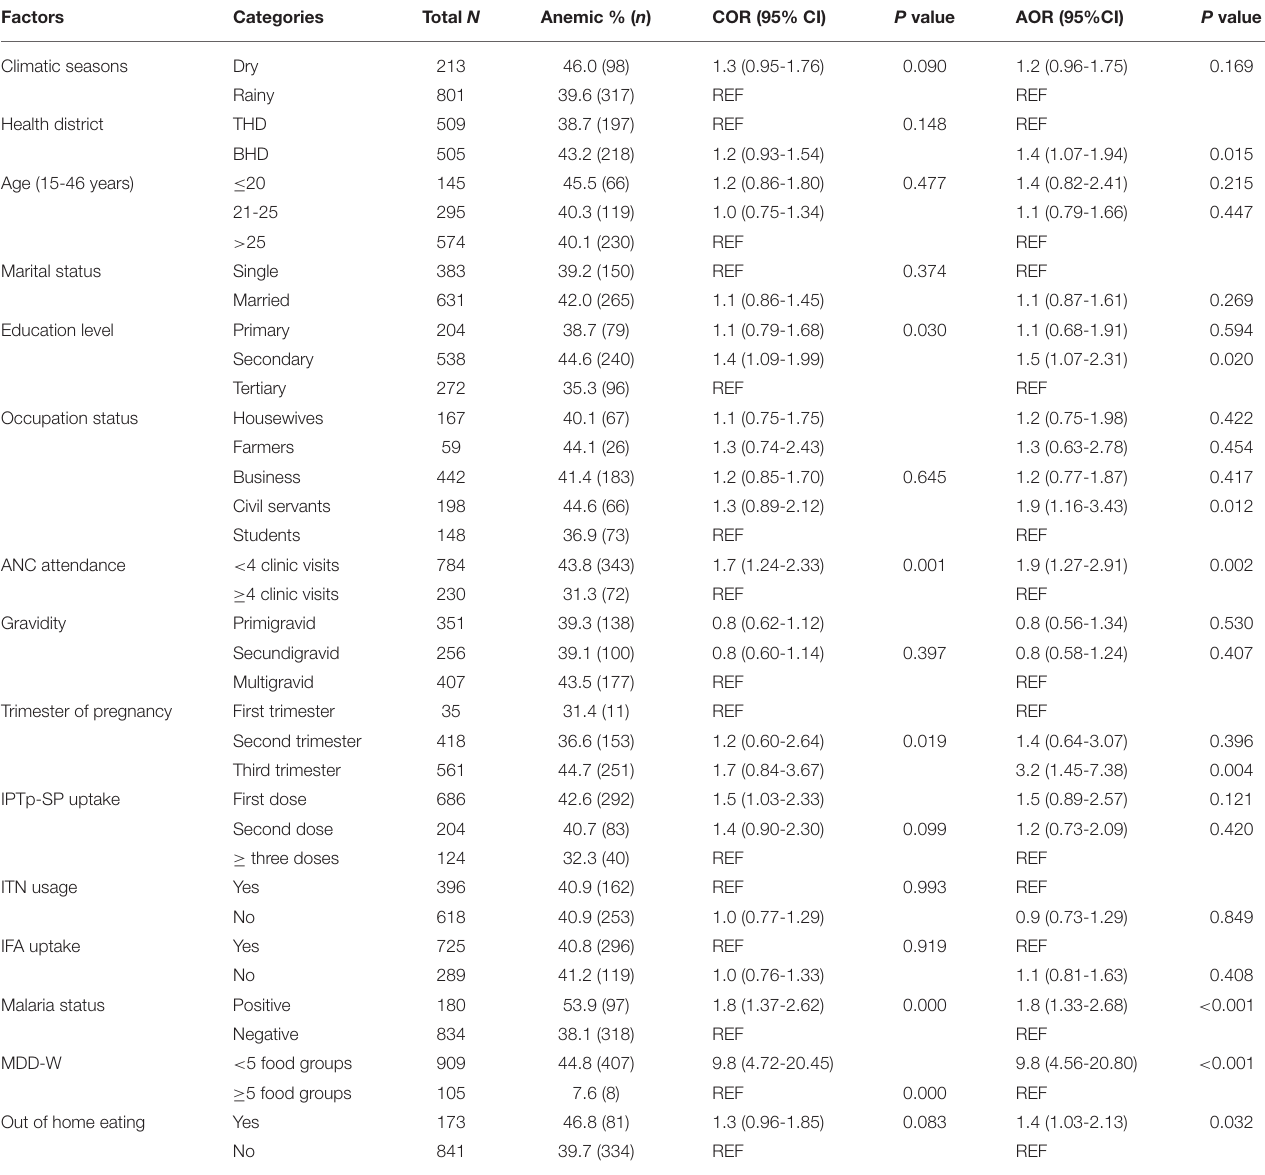
TABLE 3 | Factors associated with maternal anemia.